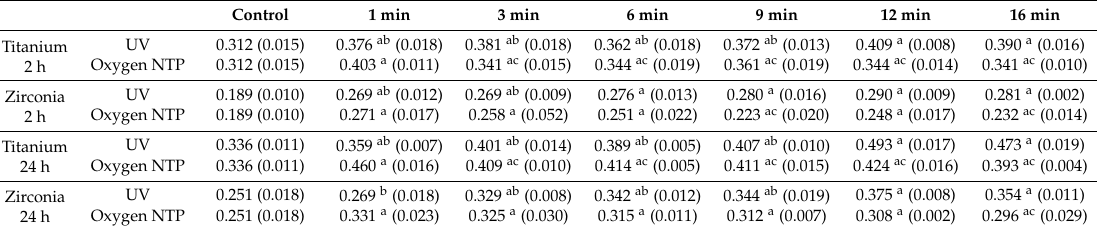
Figure 1. Viability of murine osteoblast-like cells (MC3T3-E1) on controls and time-course surface treated titanium and zirconia disks with UV-light and oxygen non-thermal plasma (NTP) after 2 ( A , B ) and 24 h ( C , D ) of incubation. Table 1. Viability of cells after 2 and 24 h of incubation. Table 2. Statistical results of one-way analysis of variance test in 12 min UV-light treated groups.